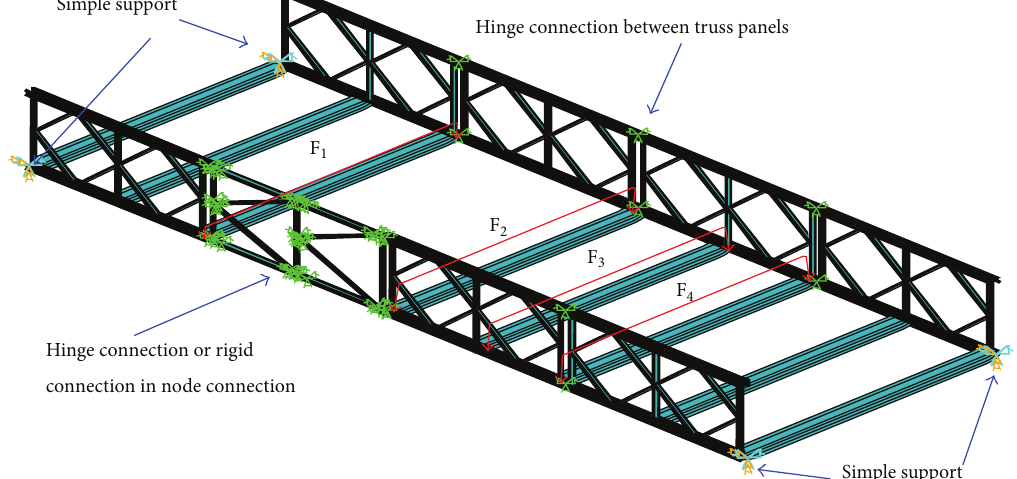
Figure 11: The finite element method model.